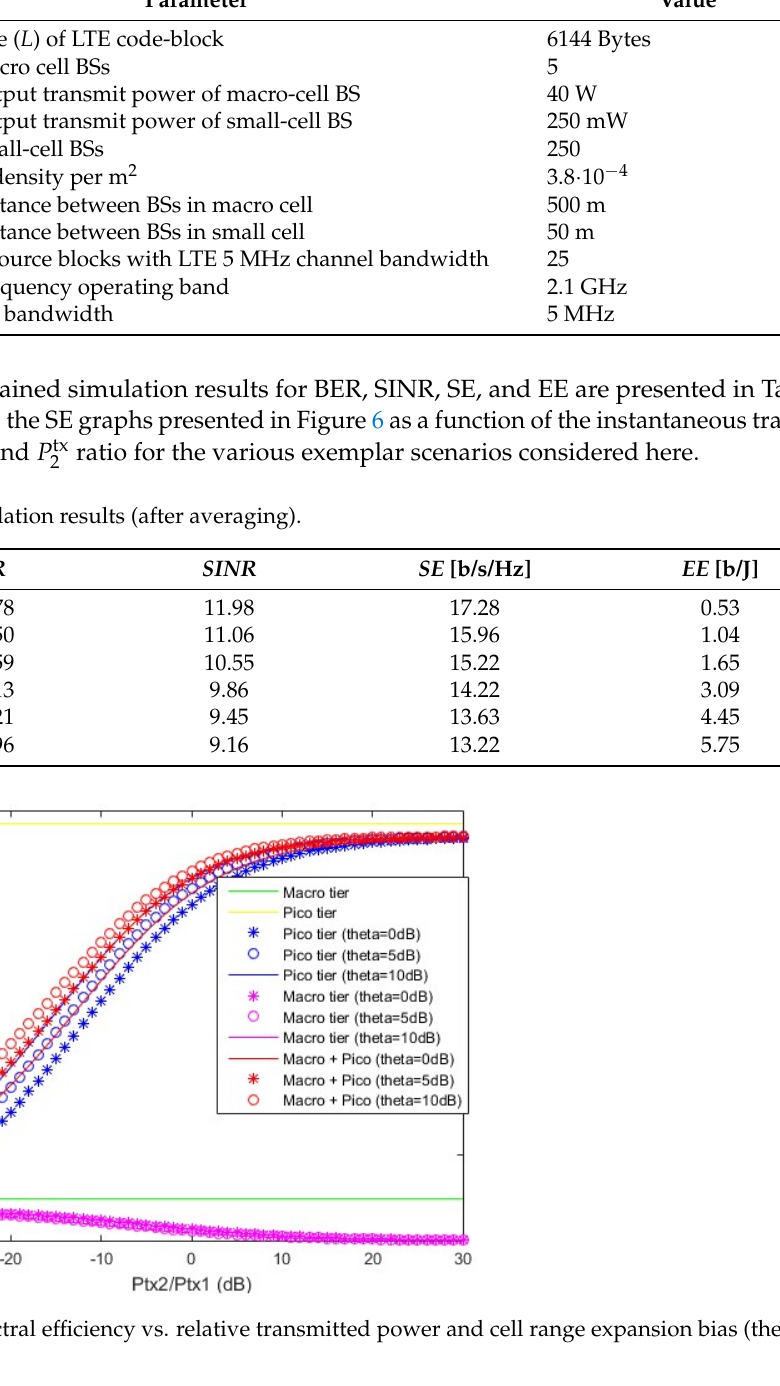
( b ) Figure 7. Simulation results for: ( a ) SE and ( b ) EE. In both the above diagrams, it can be seen that the two-tier setup scenario yielded the top efficiencies. Furthermore, the small-cell scenario (250 pico BSs) came out to be more efficient than what was achieved with macro cells (5 BSs), while still with an unchanged users’ layout and count.